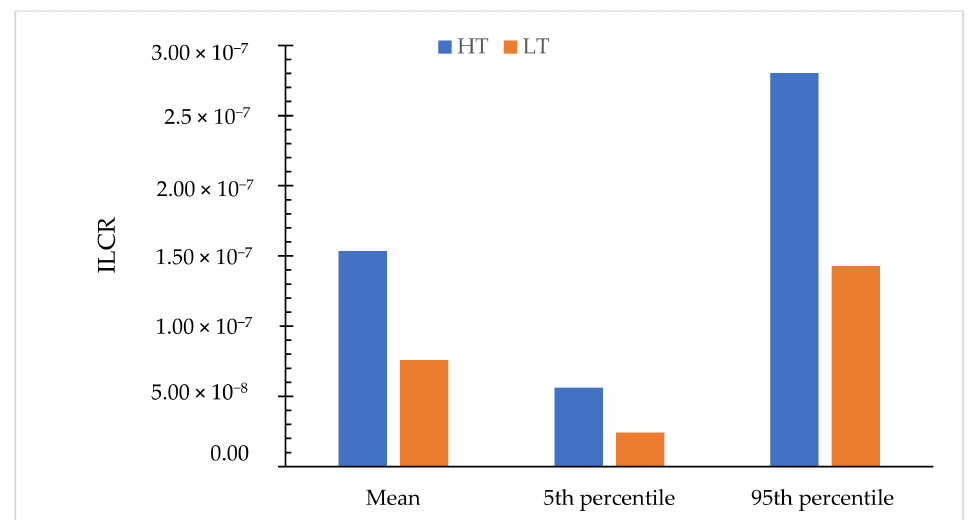
Figure 5. Probabilistic distribution of ILCR for children in HT and LT groups.